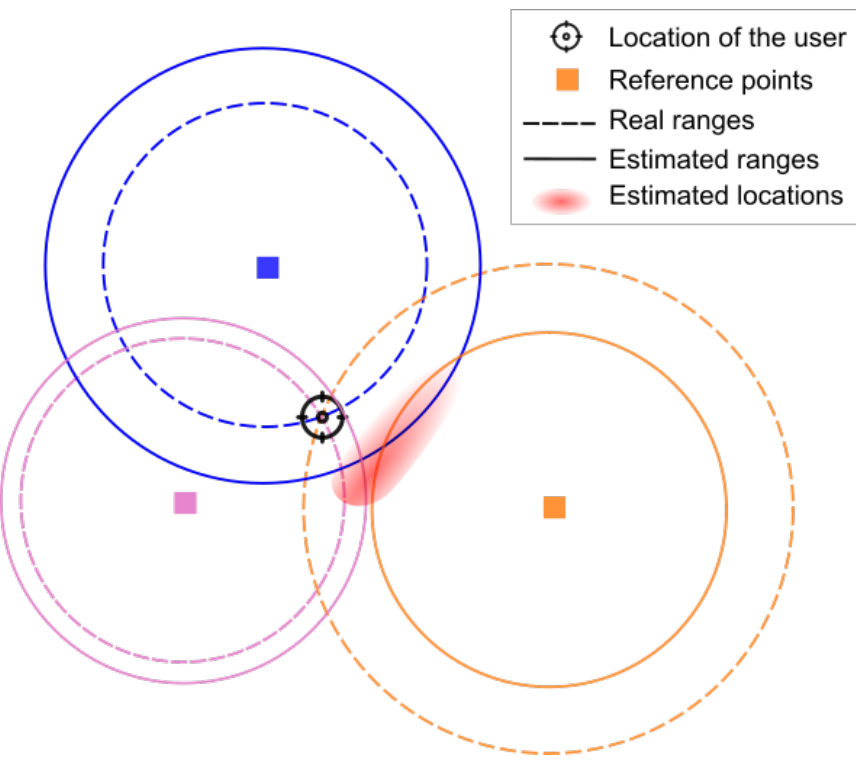
Figure 1. Location using